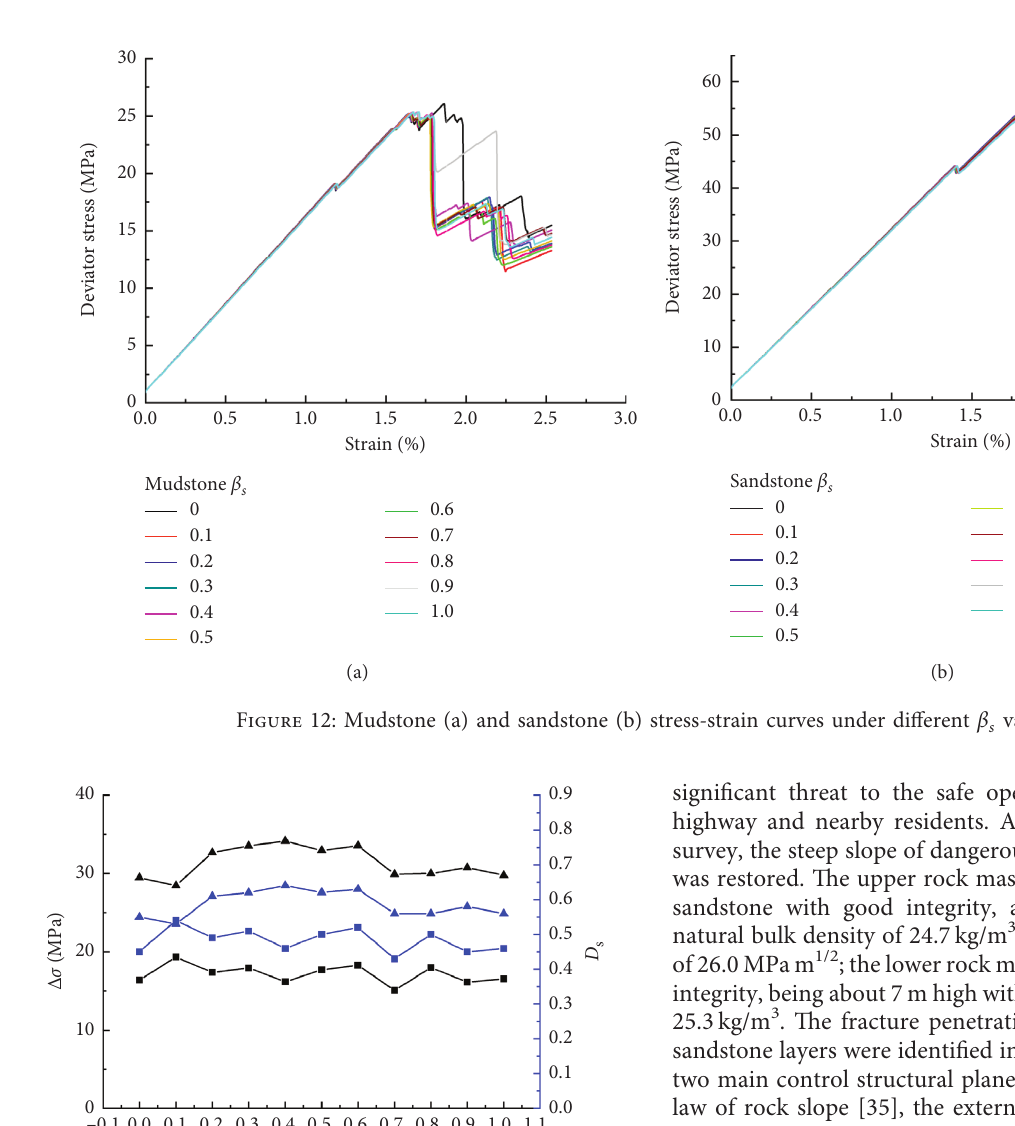
Figure 13: Intensity attenuation Δ σ and intensity attenuation coefficient D s of the two rocks under different β s